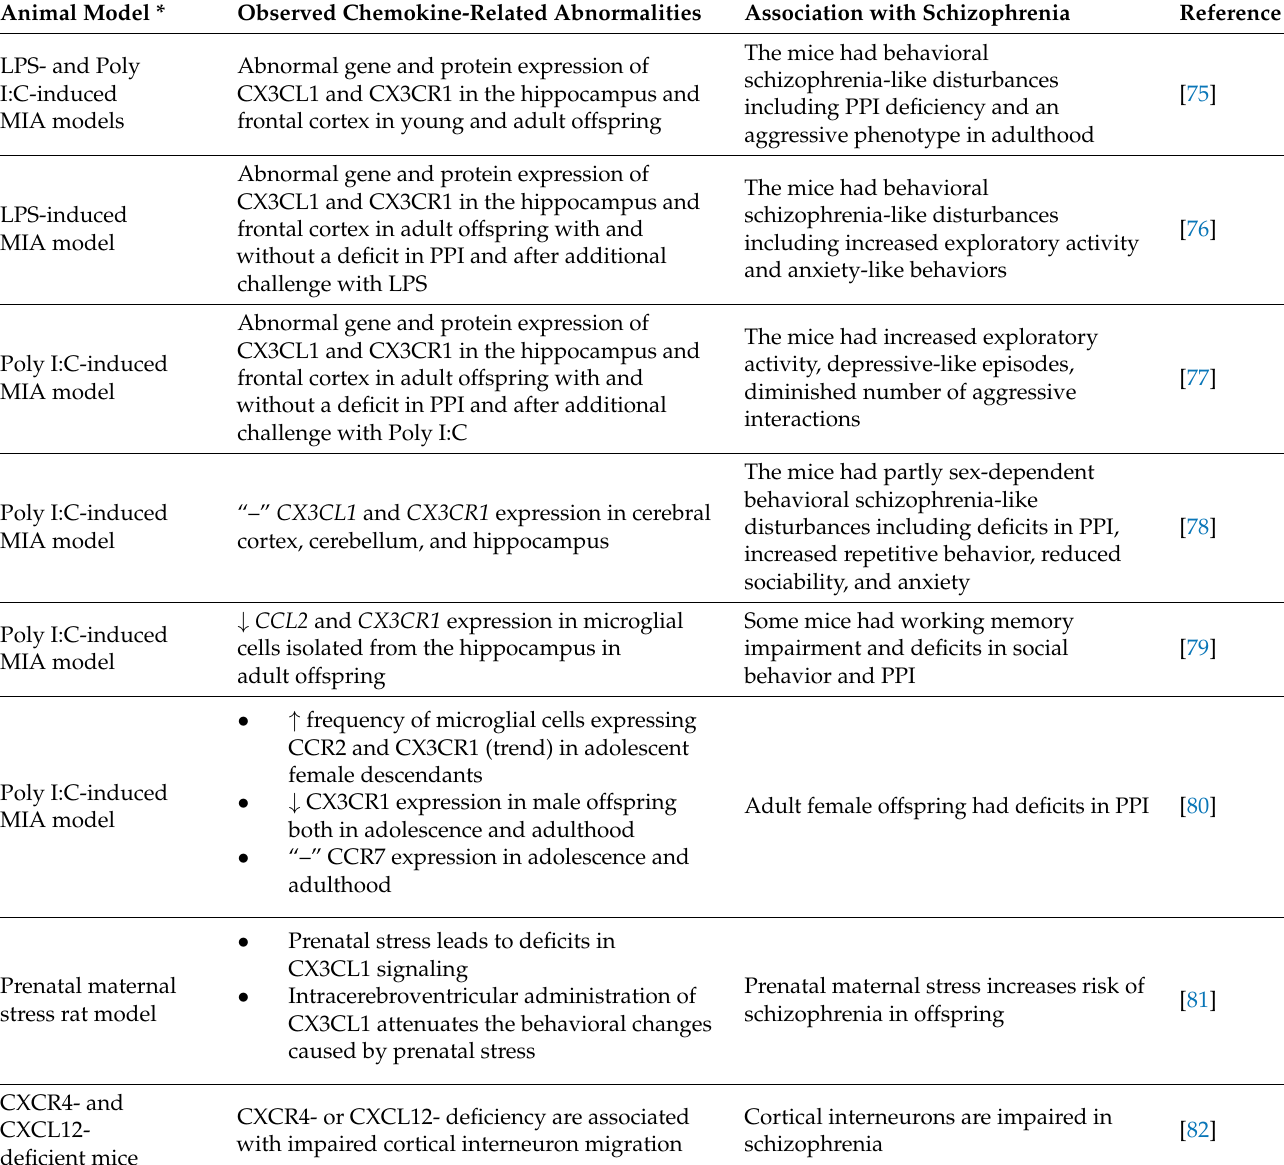
Animal models data showing the association of chemokine abnormalities in the pathogenesis of